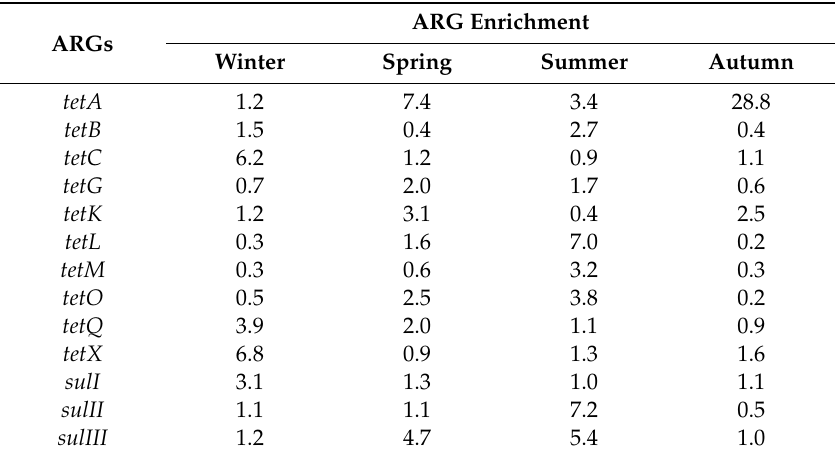
Table 3. Results of comparative qPCR analysis for